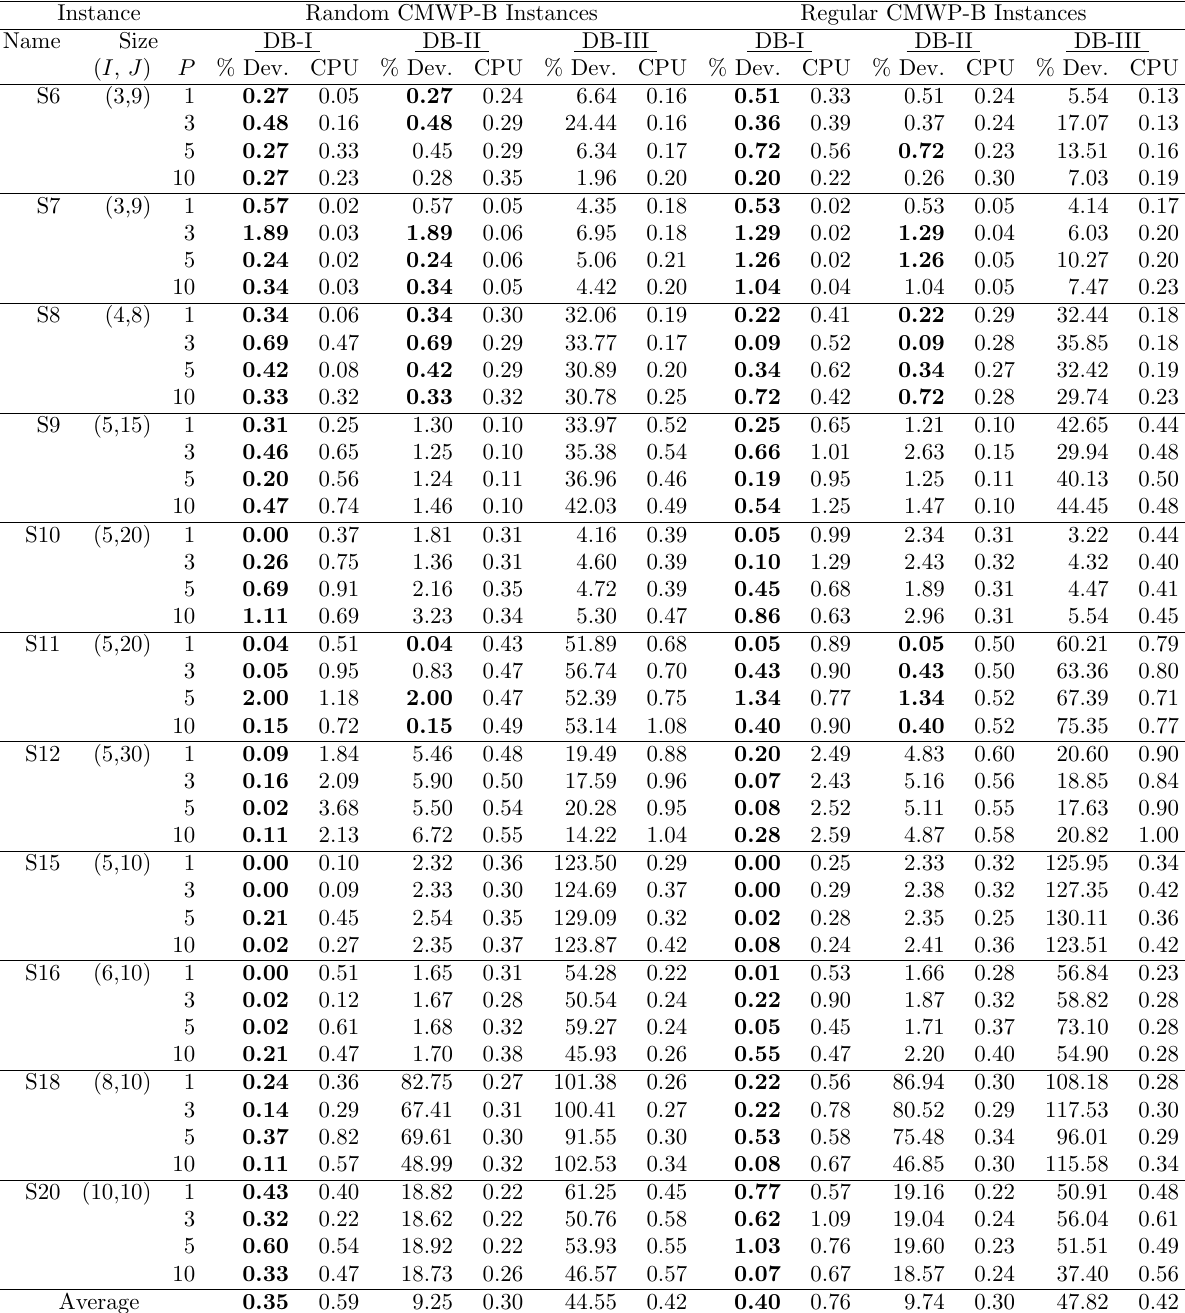
Table 2. The performance of the DB heuristics over random and regular CMWP-B instances based on Sherali et al. [19]